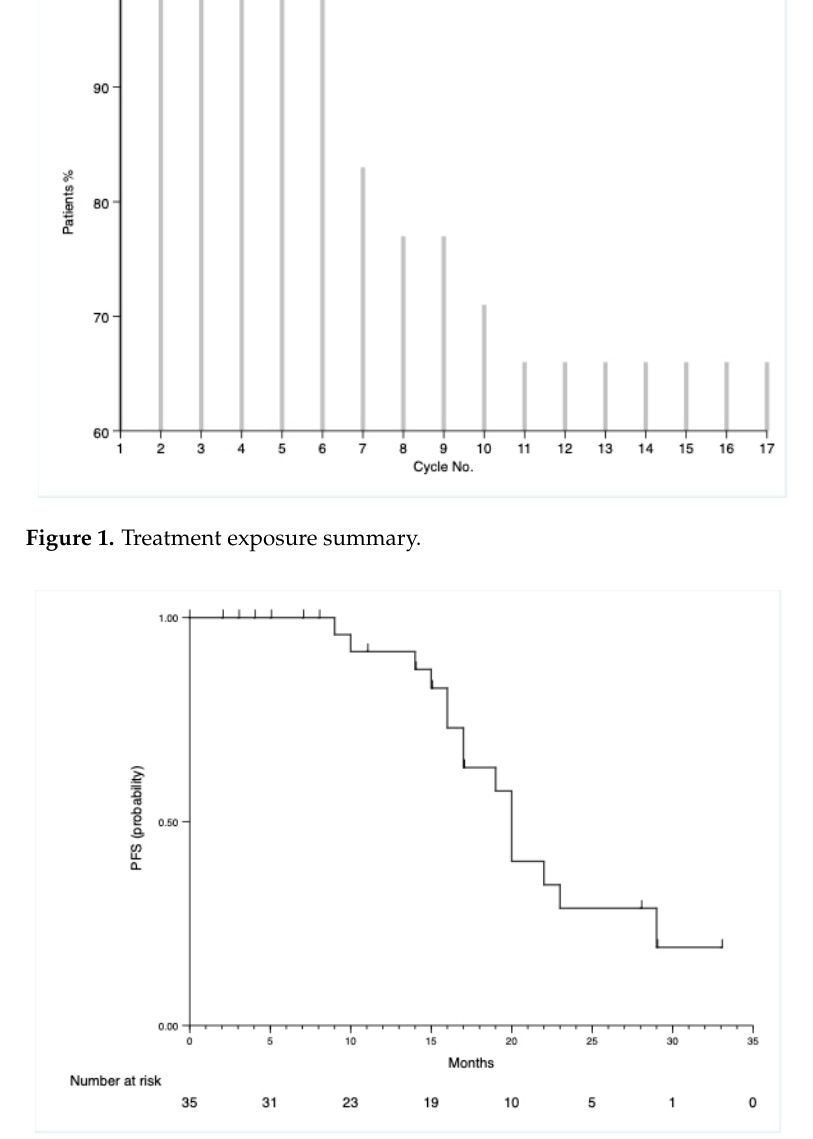
Figure 2. Kaplan-Meier estimates of progression-free survival (PFS) based on investigator assessment. Table 2. Subgroup analysis for the age of progression-free survival (PFS) and the overall survival (OS). PFS, No. of OS, No. of Subgroup Events/No. of PFS, Median Events/No. of OS, Median Patients Patients Age, years <65 7/20 22 2/20 NR ≥ 65 8/15 20 3/15 32 NR, not